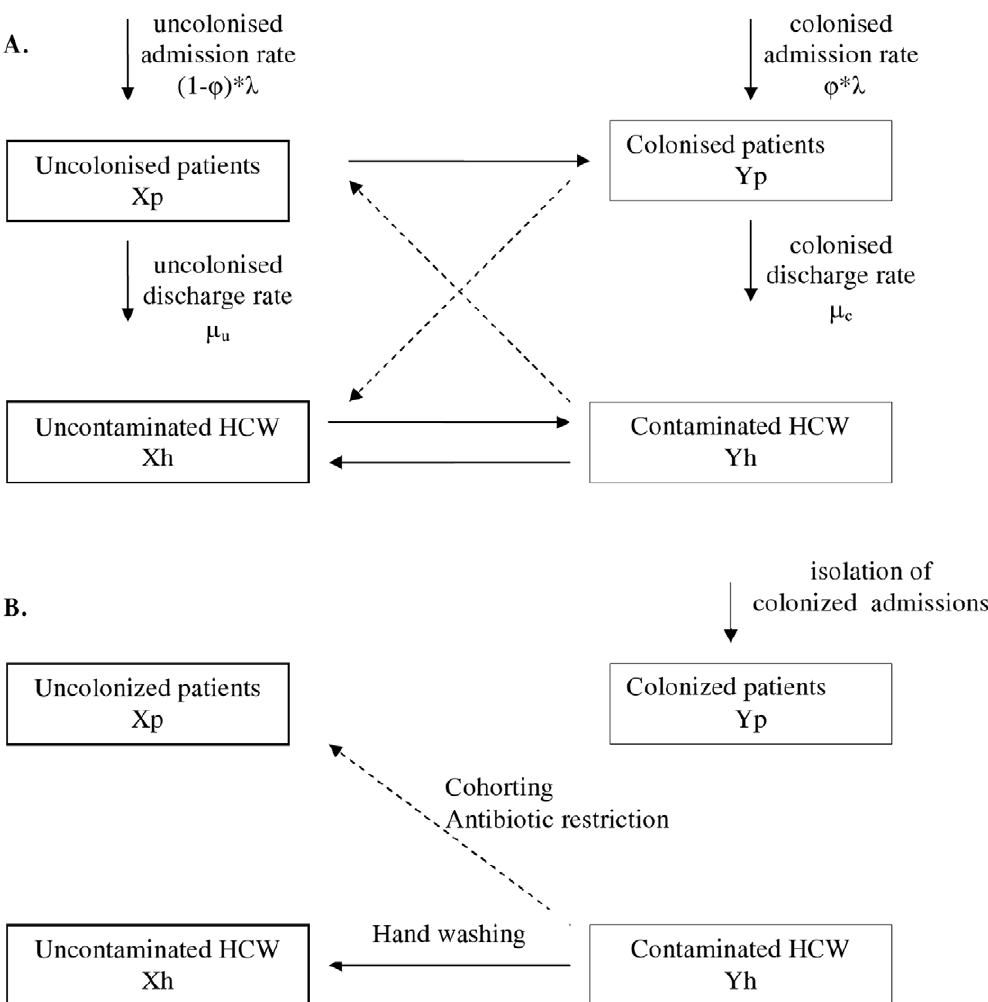
Figure 1. Model of indirect transmission of CPKP between patients through health-care workers (HCWs) and impact of intervention measures. A. Model of indirect transmission of CPKP between patients through health-care workers (HCWs) who act as vectors. Solid lines depict the movement to/from the four population groups and dashed lines depict the transmission between patients and HCWs B. The impact of intervention measures in the transmission process: hand washing (allows the decontamination of HCWs), staff cohorting (reduces patients mixing with contaminated HCWs), antibiotic restriction (reduces the probability of CPKP colonization per contact with contaminated HCW), screening and isolation of colonized admissions.